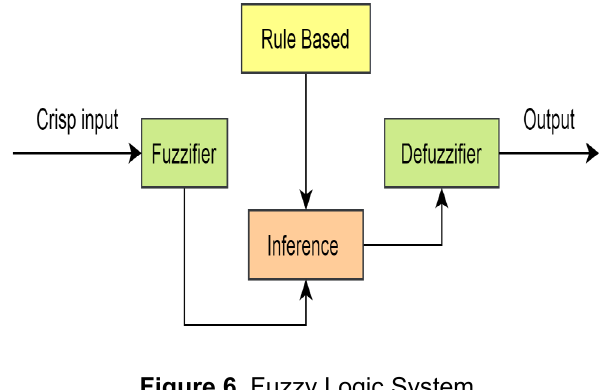
Figure 6. Fuzzy Logic